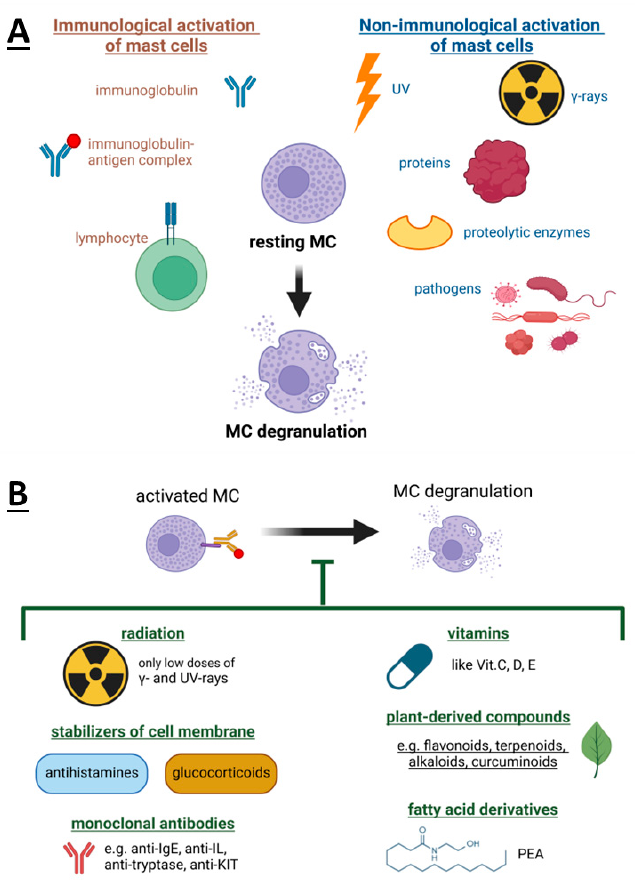
Figure 2. Mast cell degranulation can be stimulated by non-immunological and immunological factors ( A ), but this process can be also inhibited by various groups of compounds and factors ( B ). Figure created with BioRender.com.